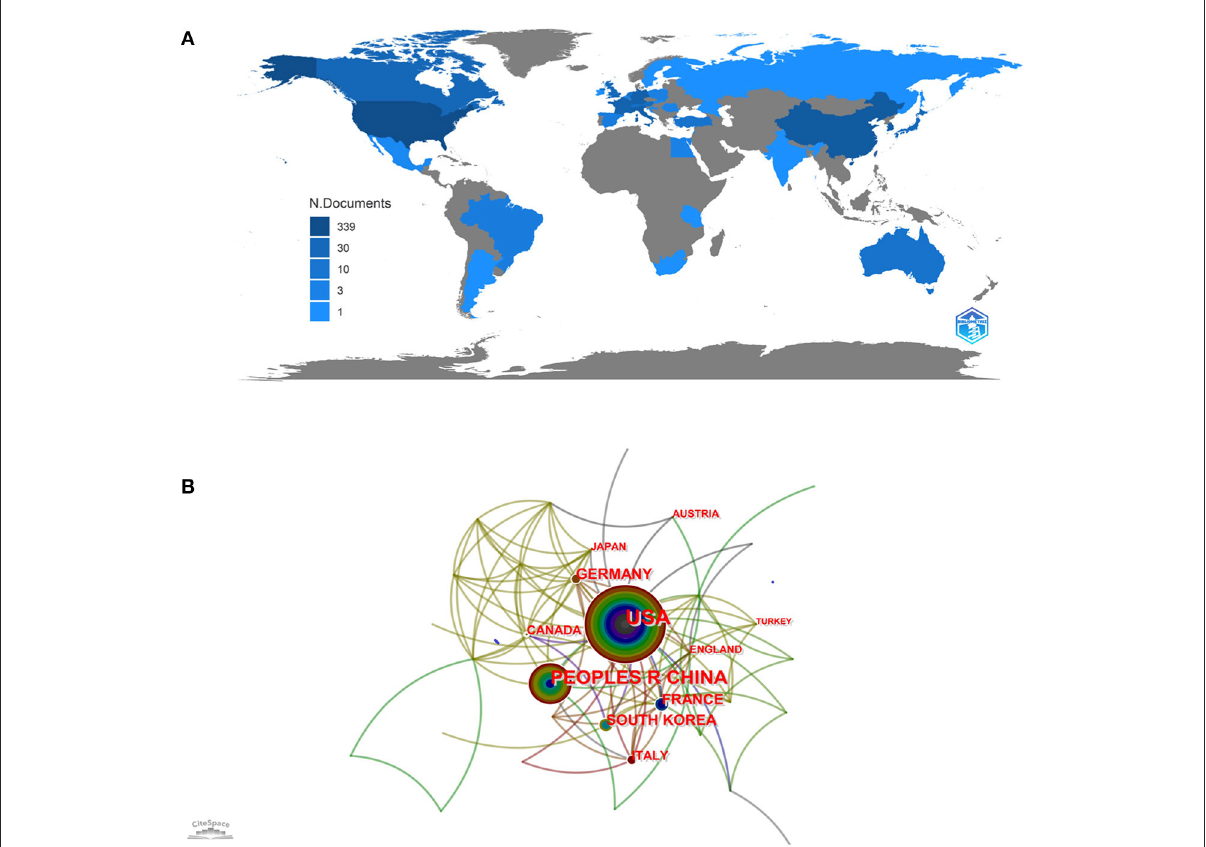
FIGURE4 (A) Country-specific production. Dark blue = high productivity. Gray = no documents. (B) Country cooperation network map. The size of each node represents the number of publications published by the country, and the thickness of each link represents the strength of the cooperative relationship between two countries.